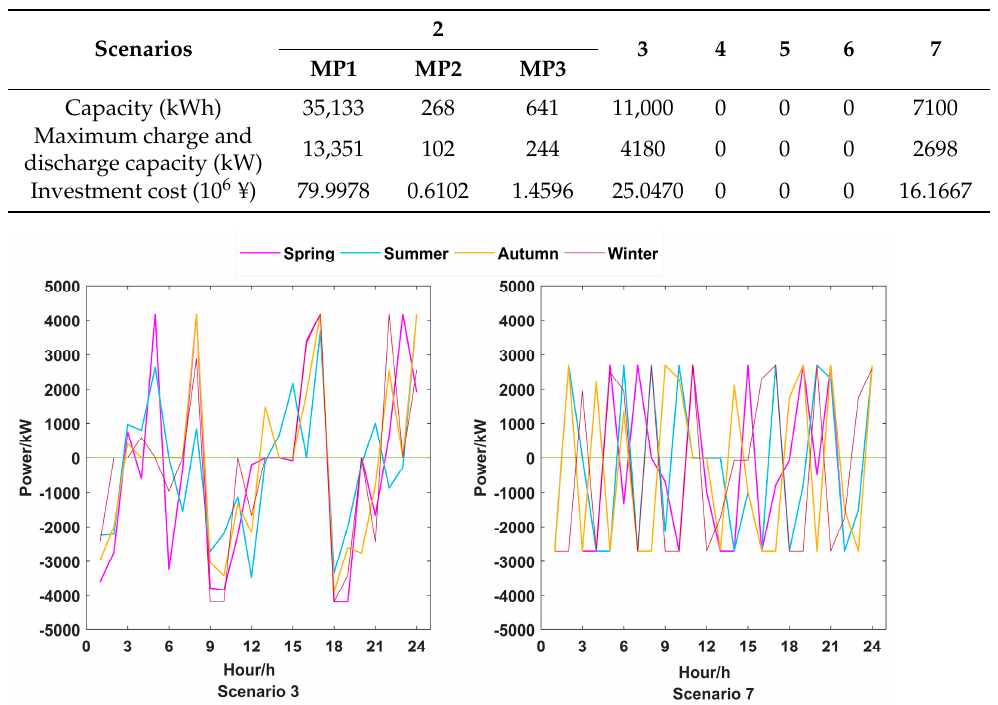
Table 3. Storage capacity planning.